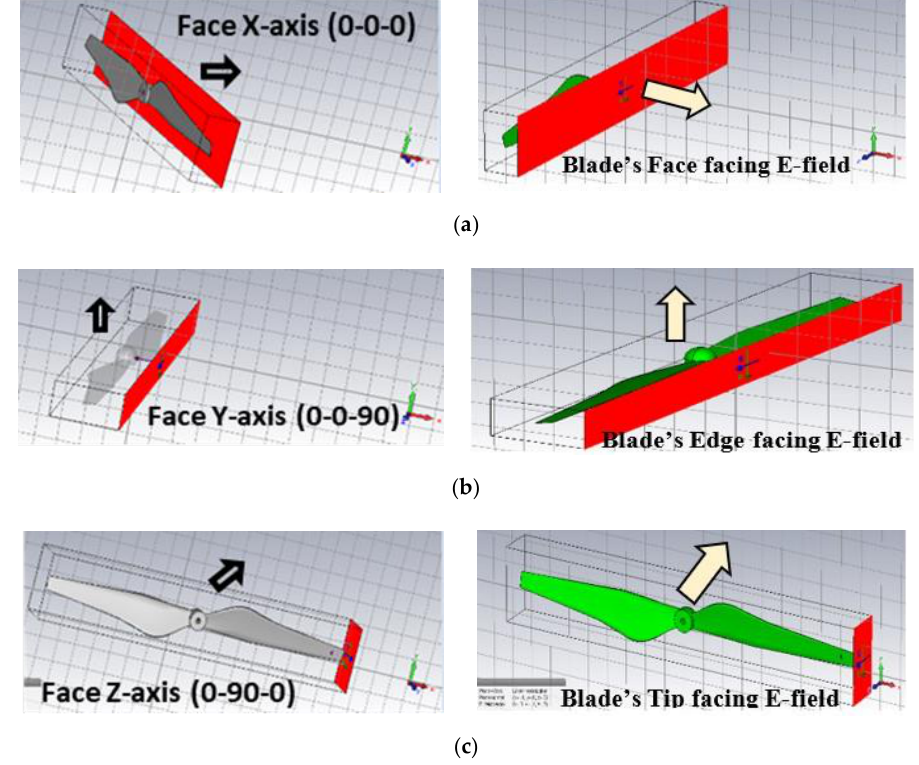
Figure 2. E-field facing the direction of the blade’s ( a ) Face ( b ) Edge ( c ) Tip.